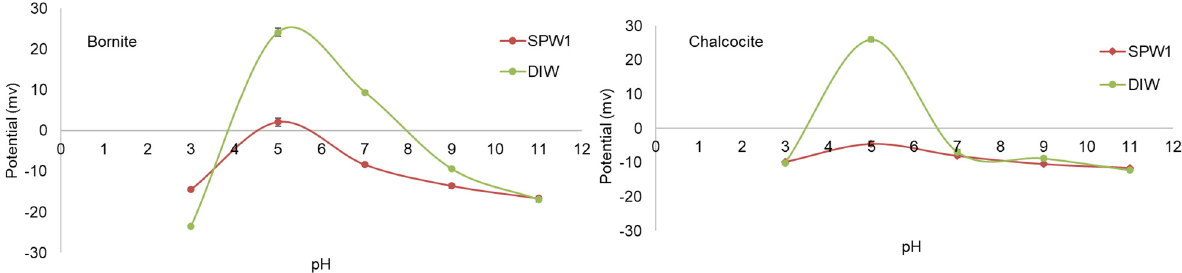
Figure 5. Zeta potential profiles for bornite and chalcocite in SPW1 and DIW at different pH levels .